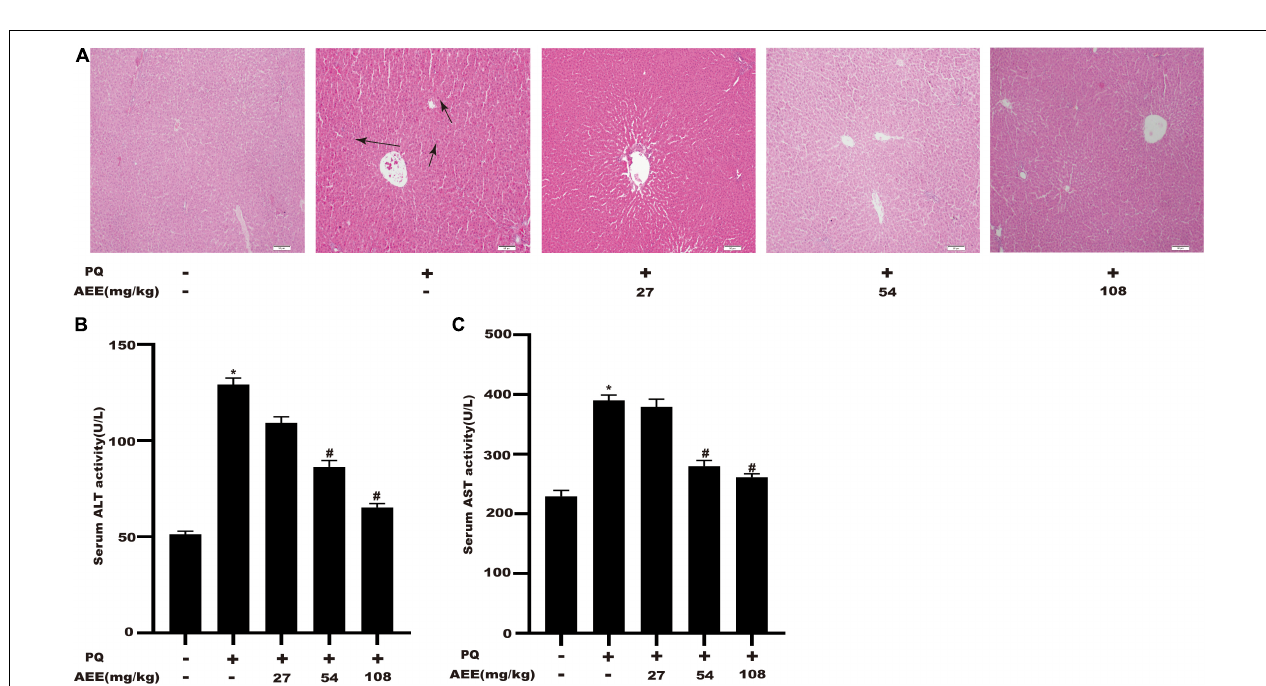
FIGURE 4 | AEE mitigates PQ-induced apoptosis in BRL-3A cells. (A) The double stained with PE and 7-AAD results among different treatment groups. (B) The apoptosis rate among different treatment groups. (C) The caspase-3 activity of BRL-3A cells was determined in different treatment groups. (D,E) The expression of caspase-3 protein in BRL-3A cells was measured in different treatment groups. (D,F) The protein expression levels of Bcl-2 and Bax in BRL-3A cells were measured in different treatment groups. Values are presented as the means ± SD where applicable ( n = 6). * p < 0.05 compared with the control group; # p < 0.05 compared with the PQ group.